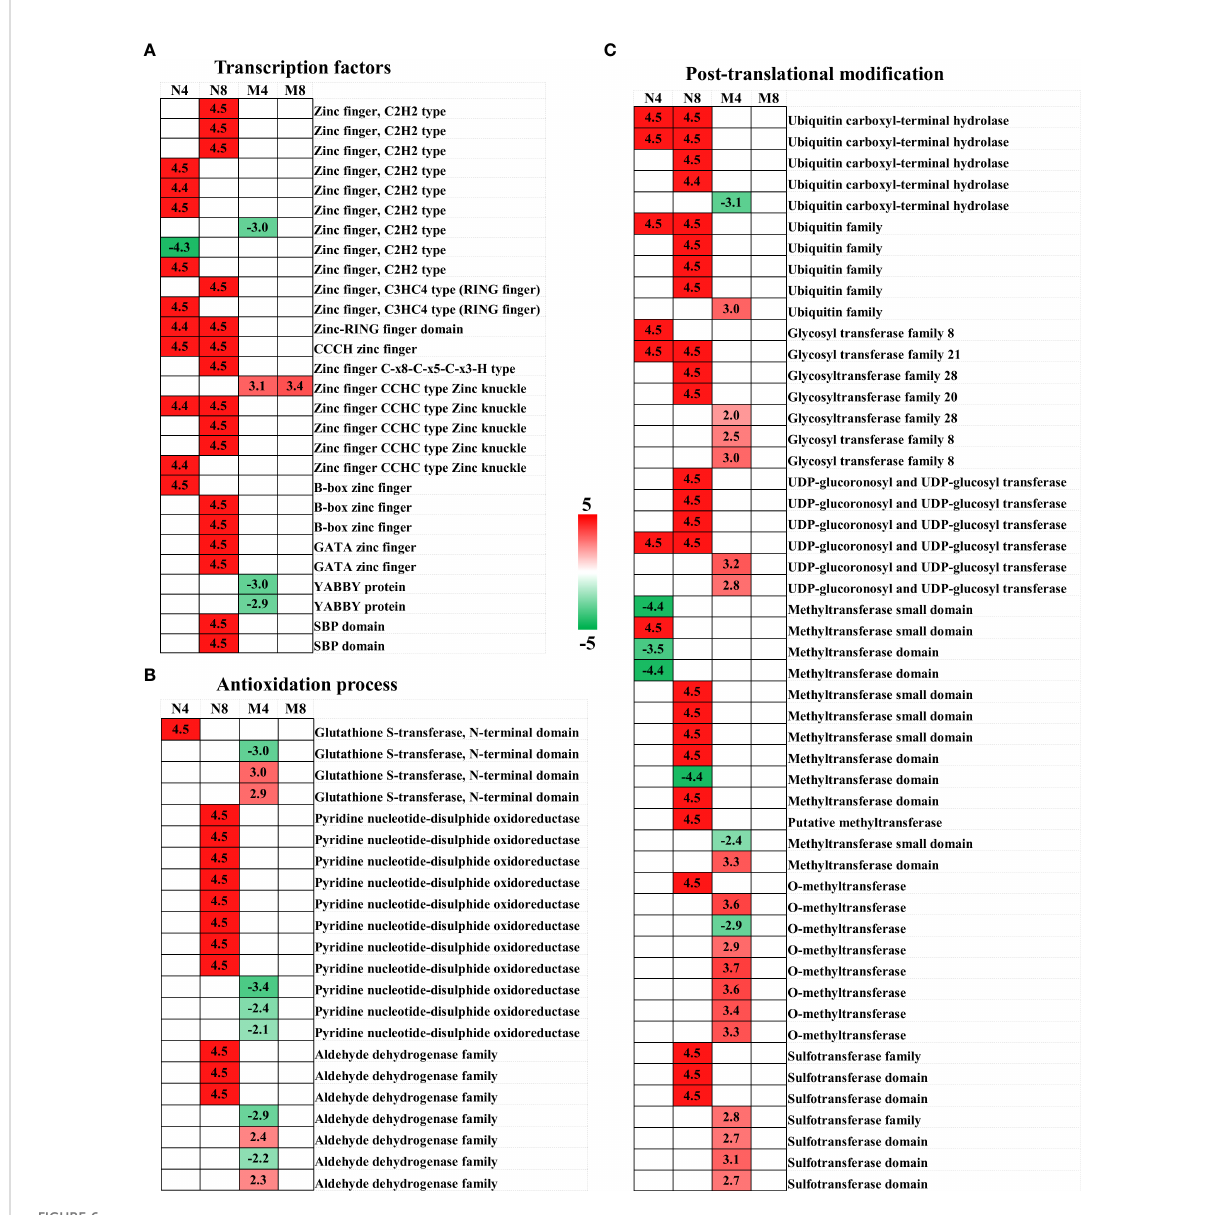
FIGURE 6 Heat map of candidate DEGs involved in transcription factors (A) , Ca 2+ sensing and transduction (B) , and post-translational modi fi cation (C) . Samples values used are log 2 (fold change). The four columns, from left to right, represent N4, N8, M4, and M8. Color key is shown on the right. Red represents up-regulation, green down-regulation, and white no signi fi cant